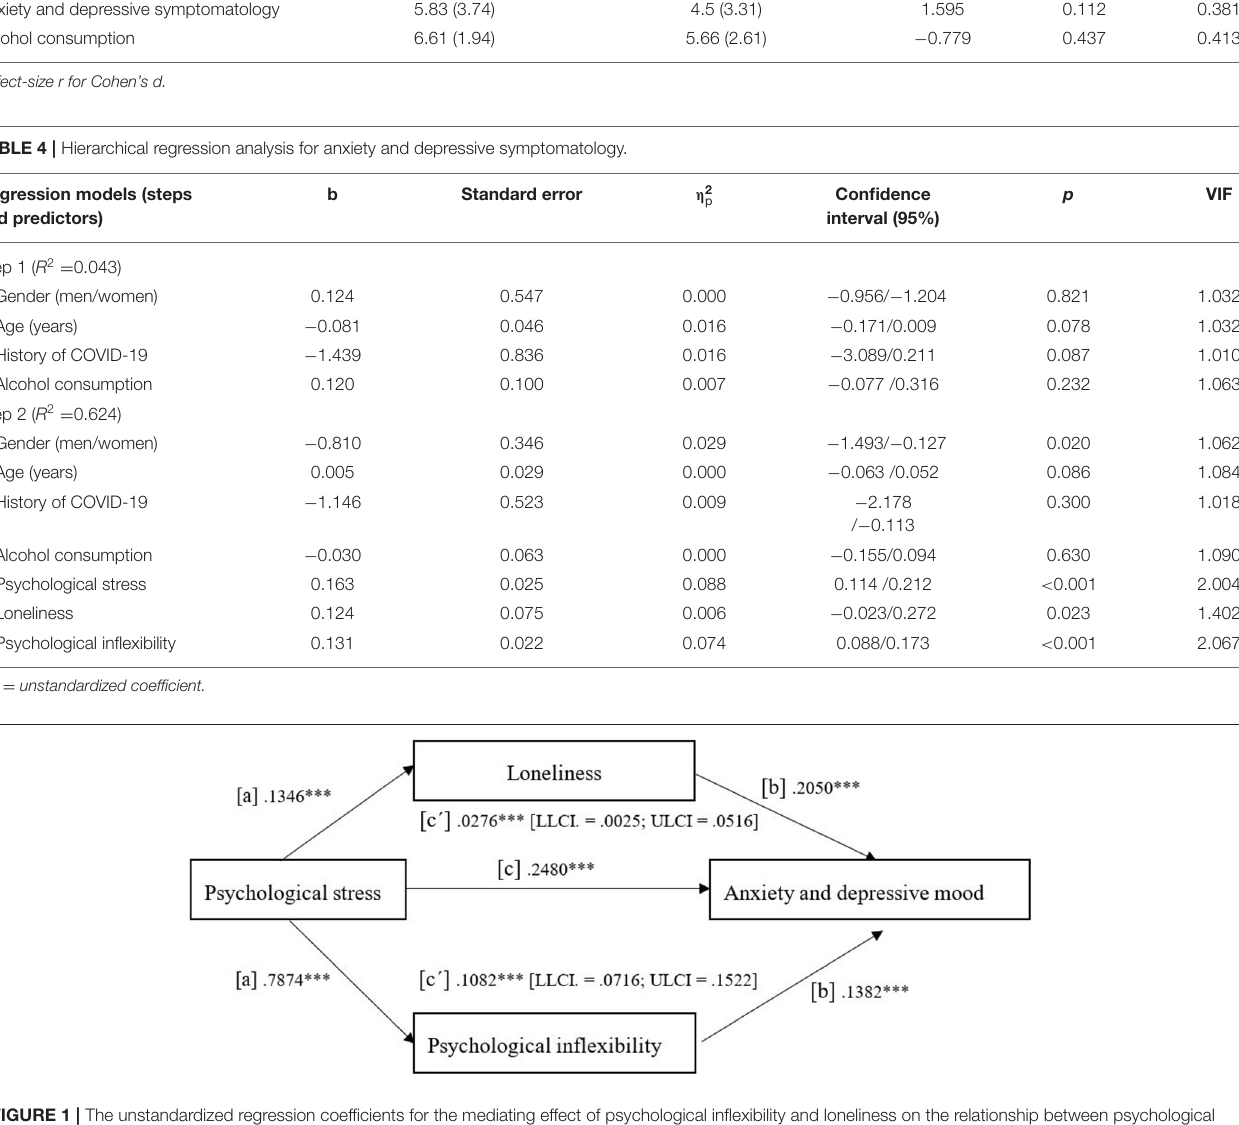
FIGURE 1 | The unstandardized regression coefficients for the mediating effect of psychological inflexibility and loneliness on the relationship between psychological stress and anxious and depressive mood. *** p <